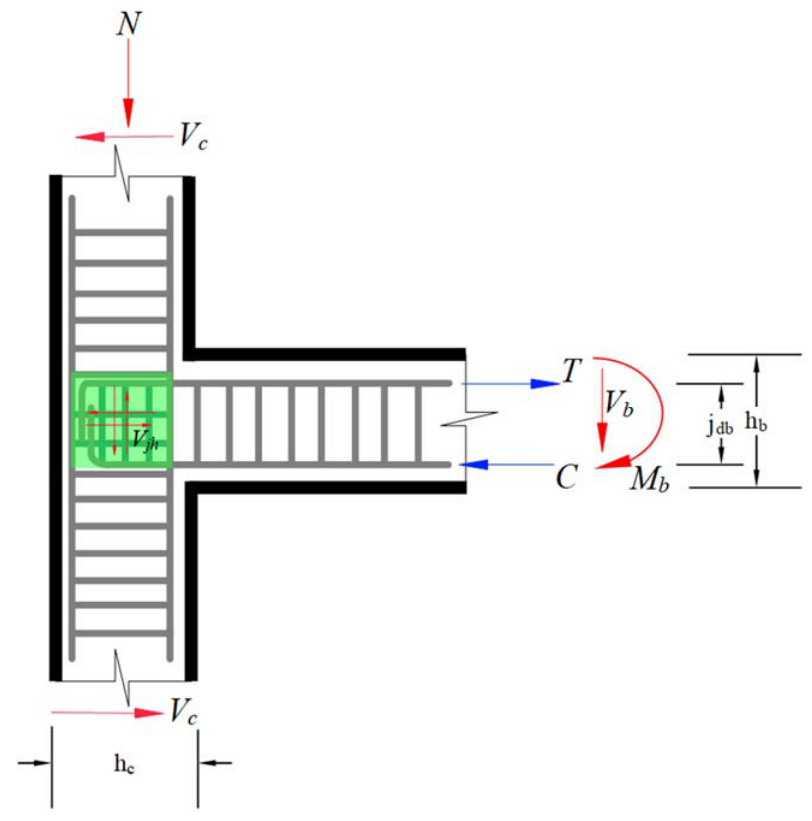
Figure 1. Cyclically ‐ loaded beam–column joint.